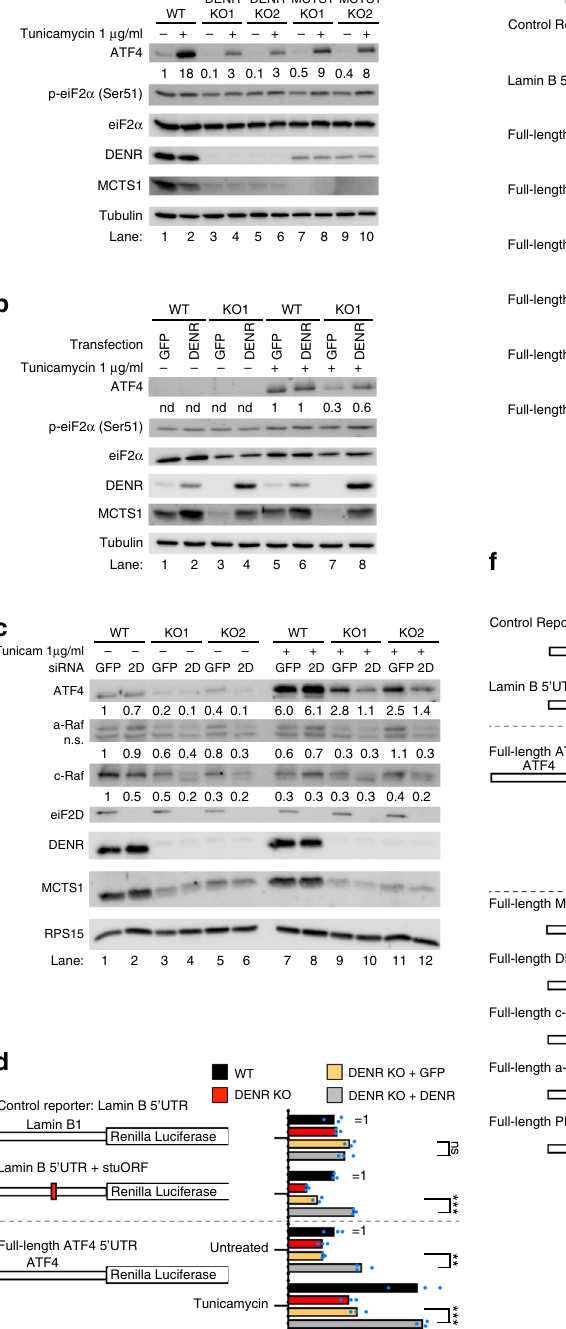
the luciferase reporter ~40% DENR dependent (Fig. 3d). Testing of uORF terminal codons in a more comprehensive manner revealed a gradation of effects, with most codons causing no DENR dependence, a few codons such as GCG Ala causing sig- ni fi cant DENR dependence (Supplementary Fig. 5b), and some codons causing intermediate DENR dependence (CTG Leu , 25% drop, Fig.